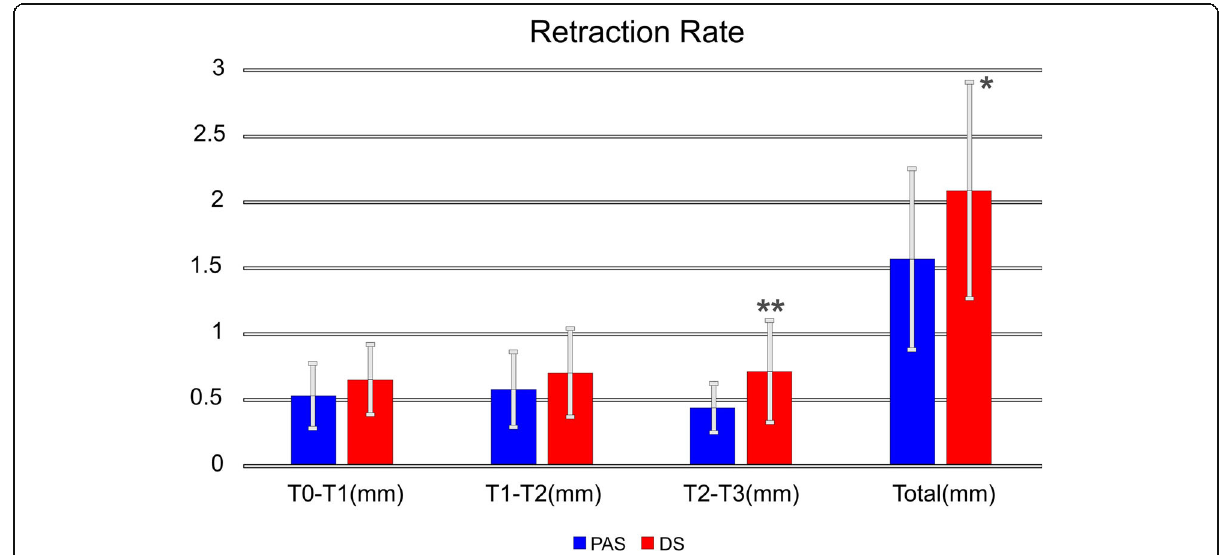
Fig. 8 Changes in monthly retraction rate. PAS, power arm sliding, DS, direct sliding, * p < 0.05 ** p < 0.01